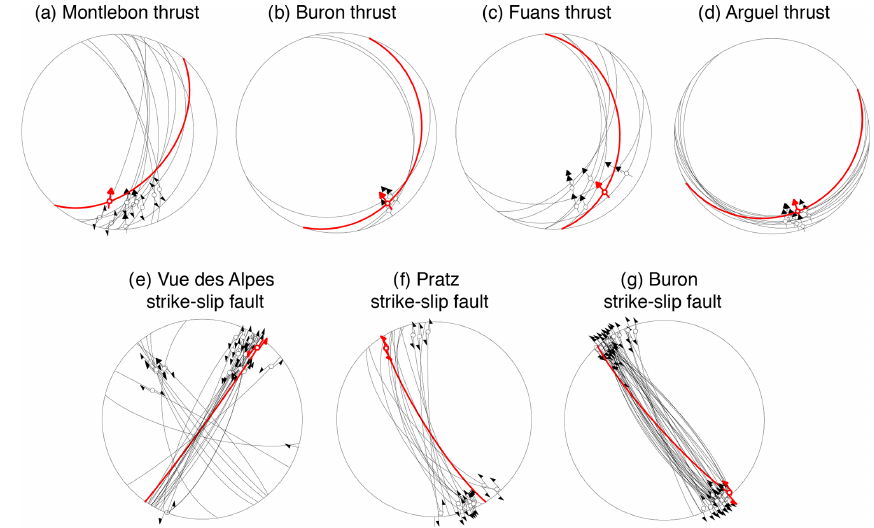
Figure 2. Lower Schmidt hemisphere projection of fault-slip data and slip vectors for thrust and strike-slip faults. Dated faults in red. (a) Montlebon thrust. (b) Buron thrust. (c) Fuans thrust. (d) Arguel thrust. (e) Vue des Alpes strike-slip fault. (f) Pratz strike-slip fault. (g) Buron strike-slip fault.